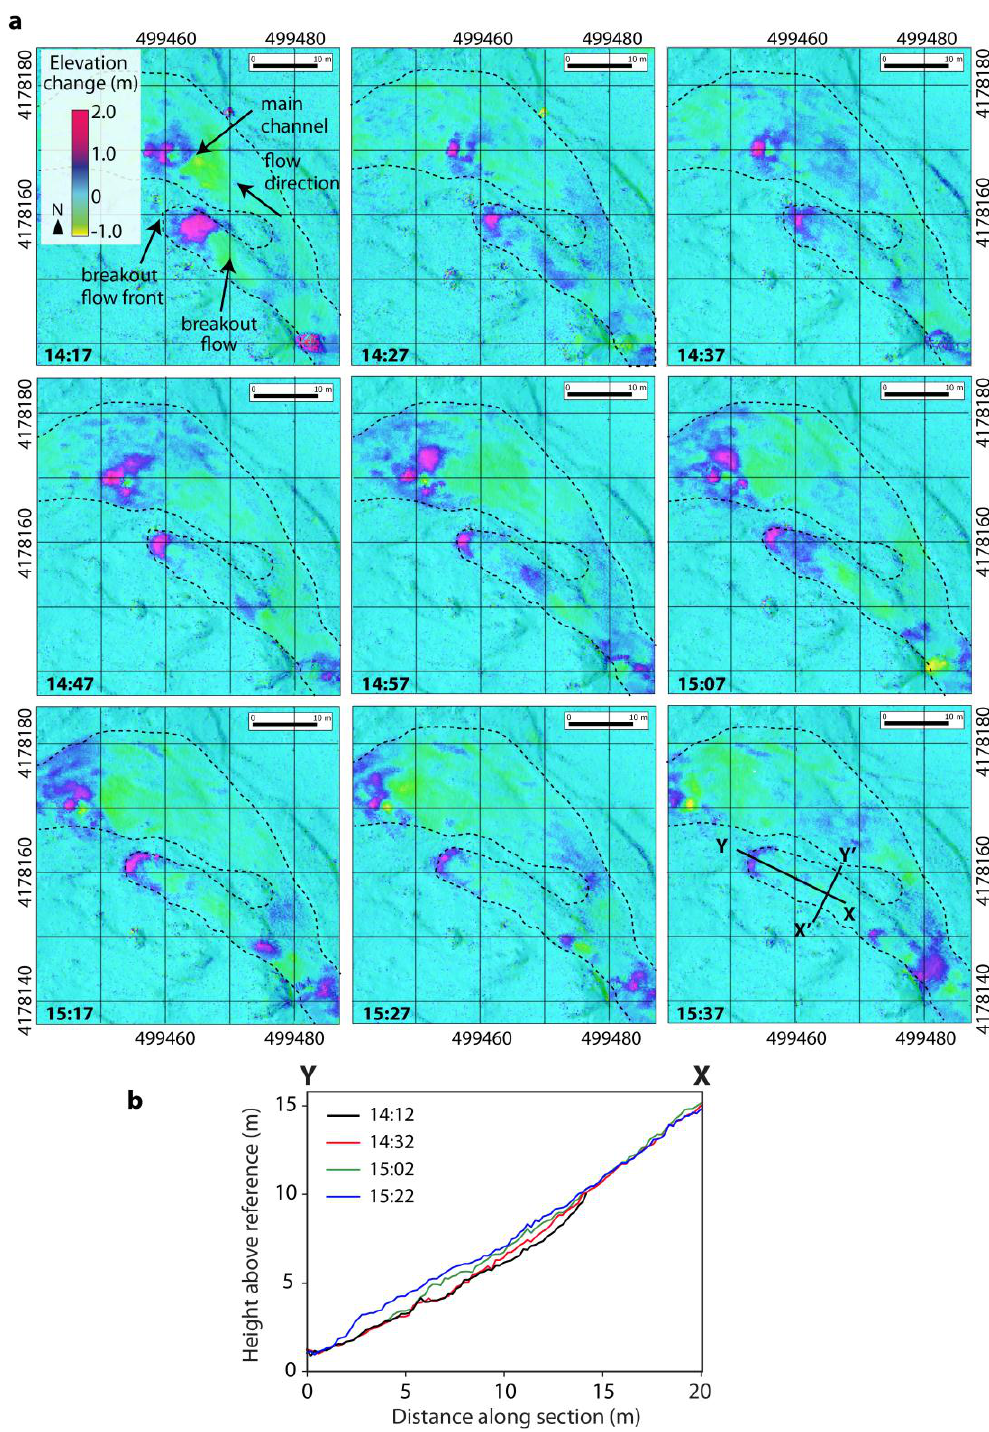
Figure 3. Elevation changes for the lava flow region from 10-minute repeat-interval TLS scans. ( a ) Difference maps with the active flow region delineated by the dashed lines (the region covered by the maps is illustrated by the dashed box in Figure 2c). The time marked on each panel denotes the time in-between the acquisitions of the differenced scans. In the panel labelled 15:37, the labelled sections are those in ( b ) (X-Y) and in Section 4.3 (X ' -Y ' ). (b) Along-flow cross-sections between the points X and Y in (a), with the times given representing the midpoint times for each